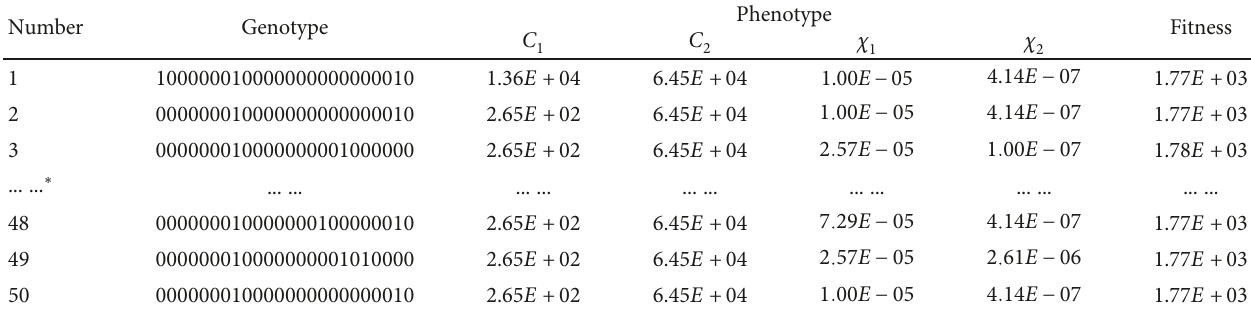
Table 2: The 1st generation population.